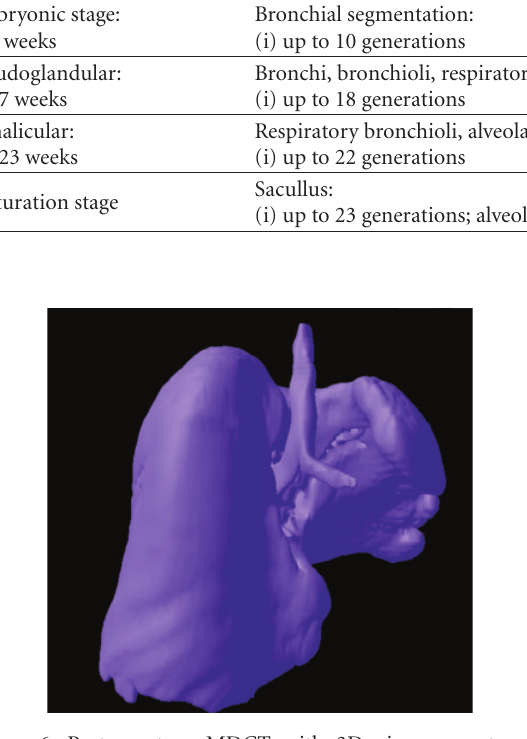
Figure 6: Postoperatory MDCT with 3D view reconstruction showing the blind-ended left main bronchia and the compensatory hyperplasic right lung.